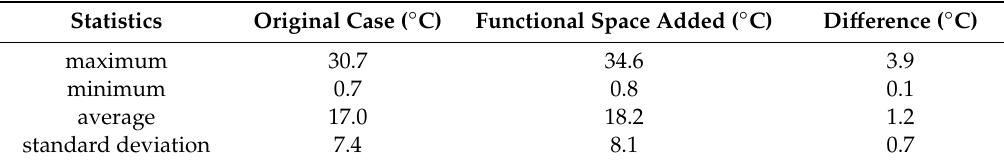
Table 3. Statistics of the air temperature in the tomb chamber.